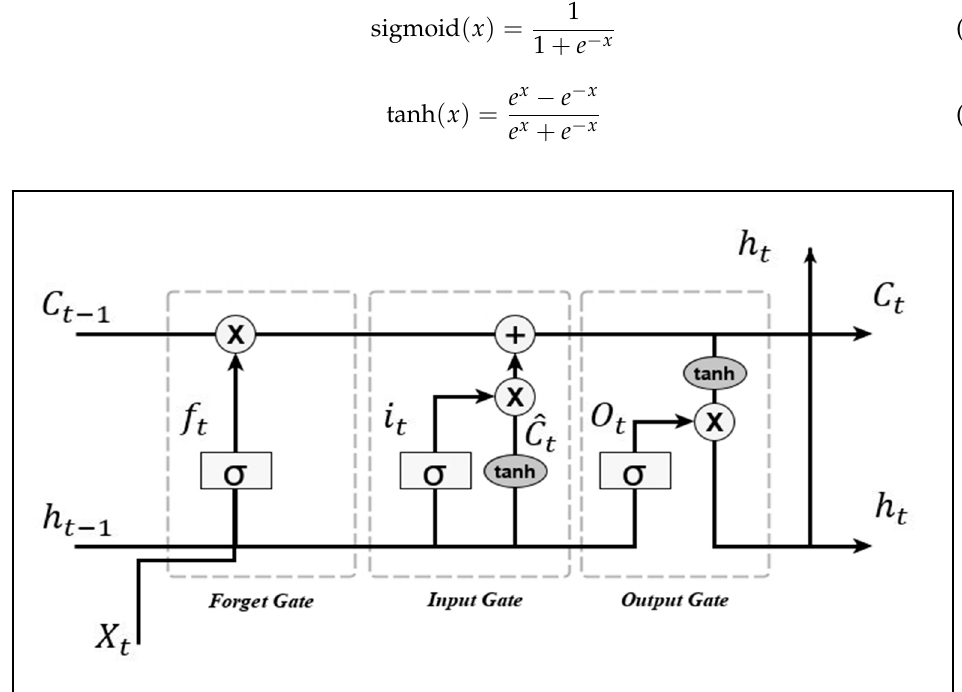
Figure 3. Architecture of LSTM.